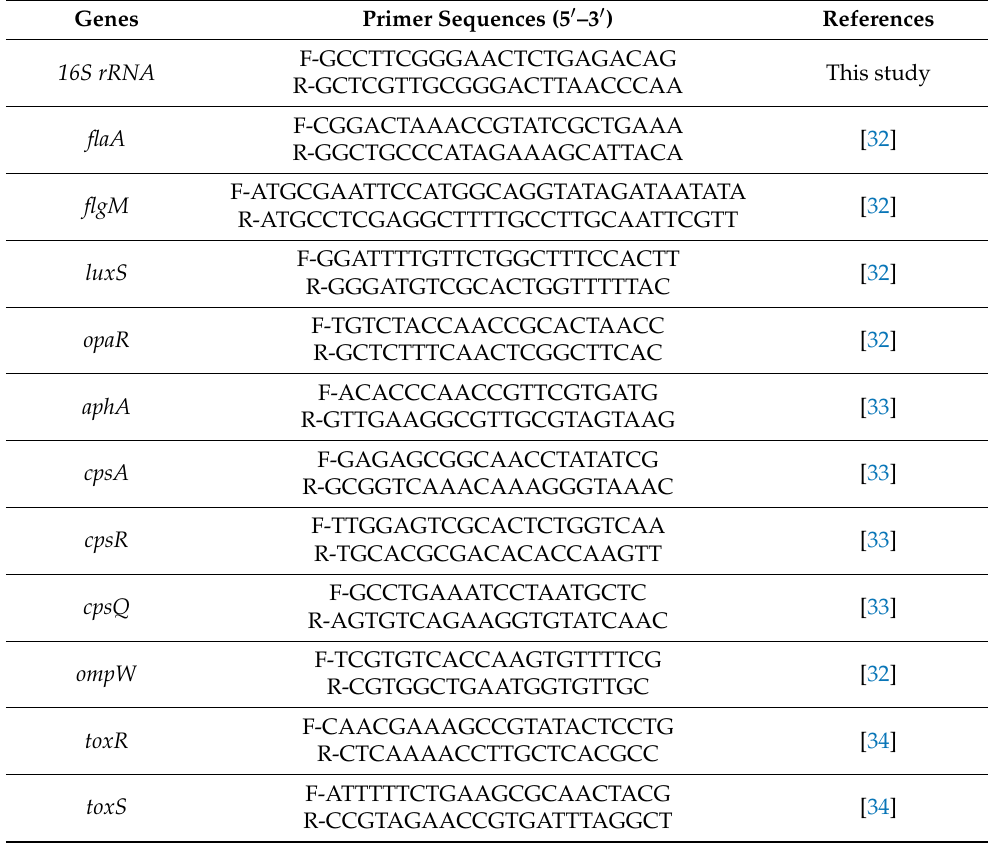
Table 1. Primer sequences of the RT-qPCR assay. Genes Primer Sequences (5 (cid:48) –3 (cid:48)